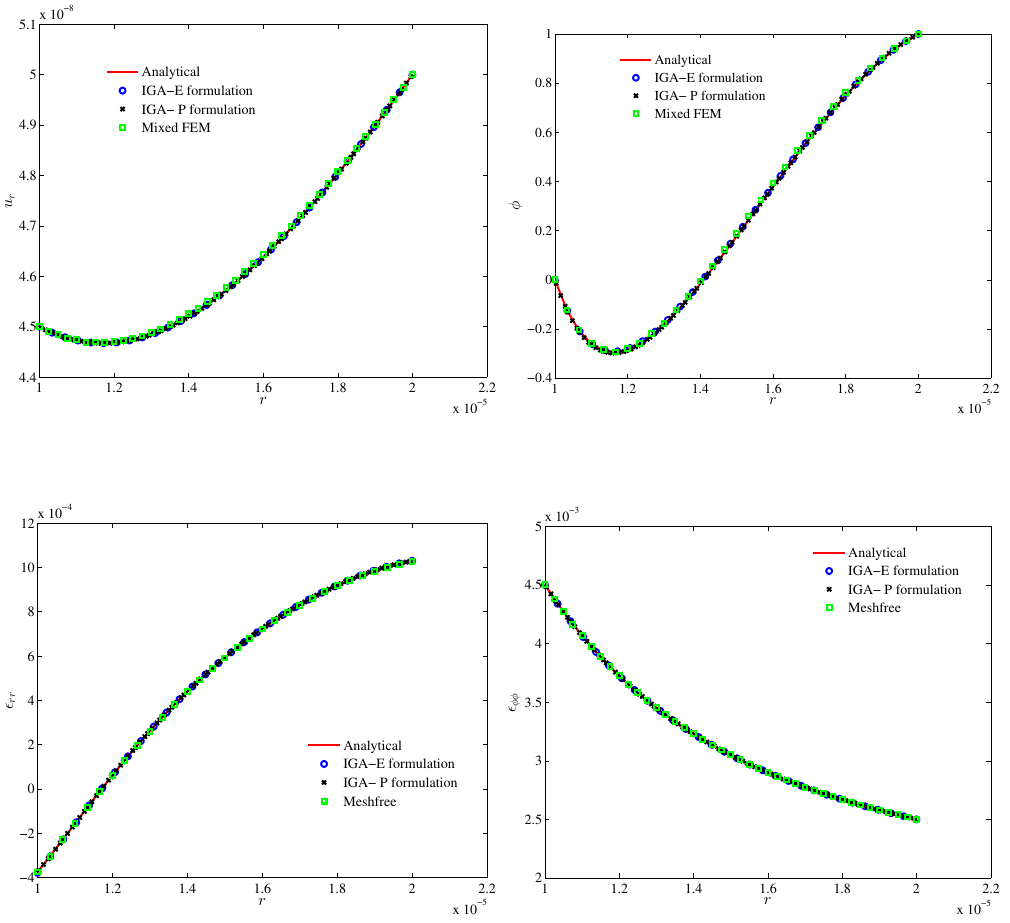
Figure 5. Comparison of the exact and numerical results for radial displacement u r , electric potential φ , radial strain ε rr and circumferential strain ε φφ as functions of radius r .